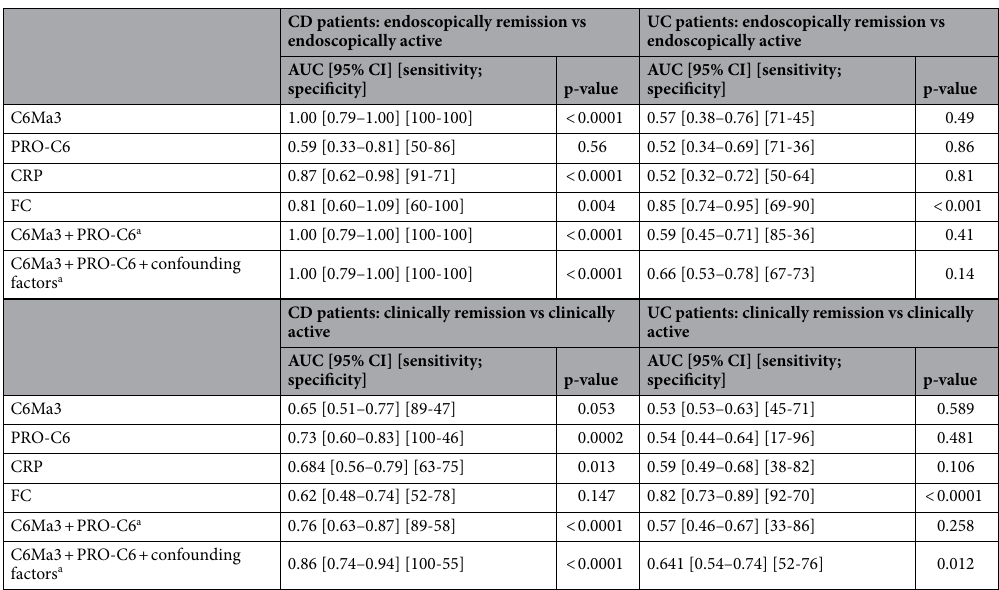
Table 5. AUROC analysis of the biomarkers in endoscopically active vs endoscopically inactive CD and UC patients. AUROC area under the receiver operating characteristic curve, AUC area under the curve, CI confidence interval. a Logistic regression model. Confounding factors: age, BMI, gender, and smoking.